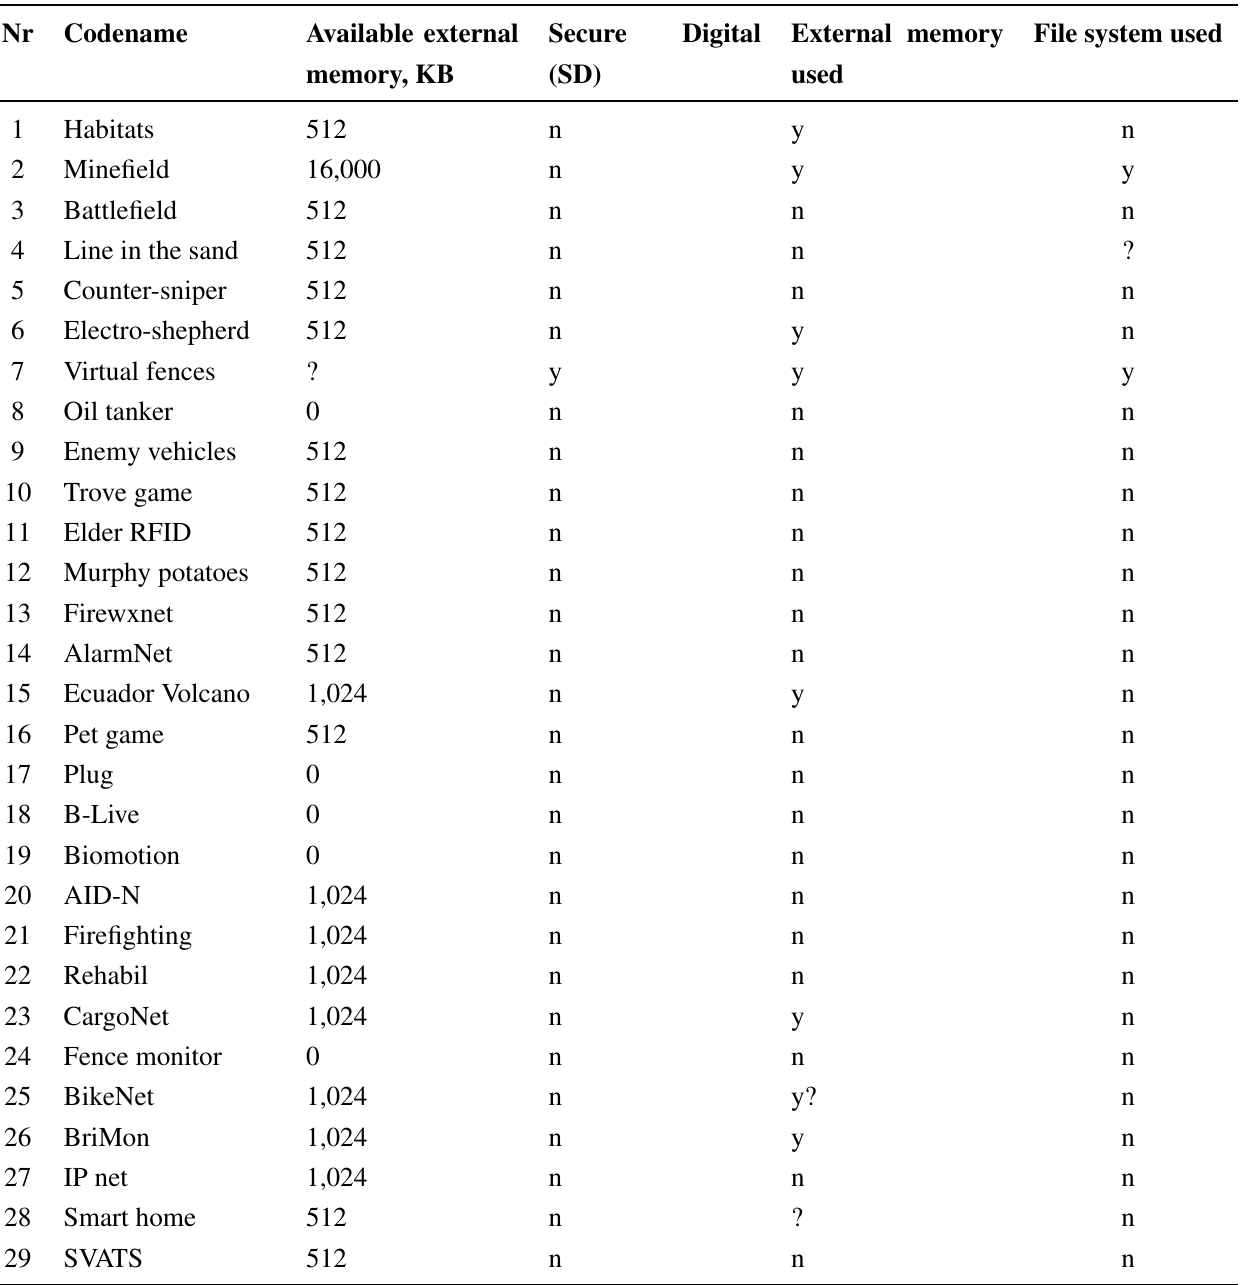
Table 7. Deployments: external